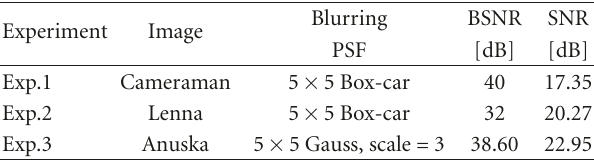
Table 1: Blurring PSF, BSNR, and SNR.